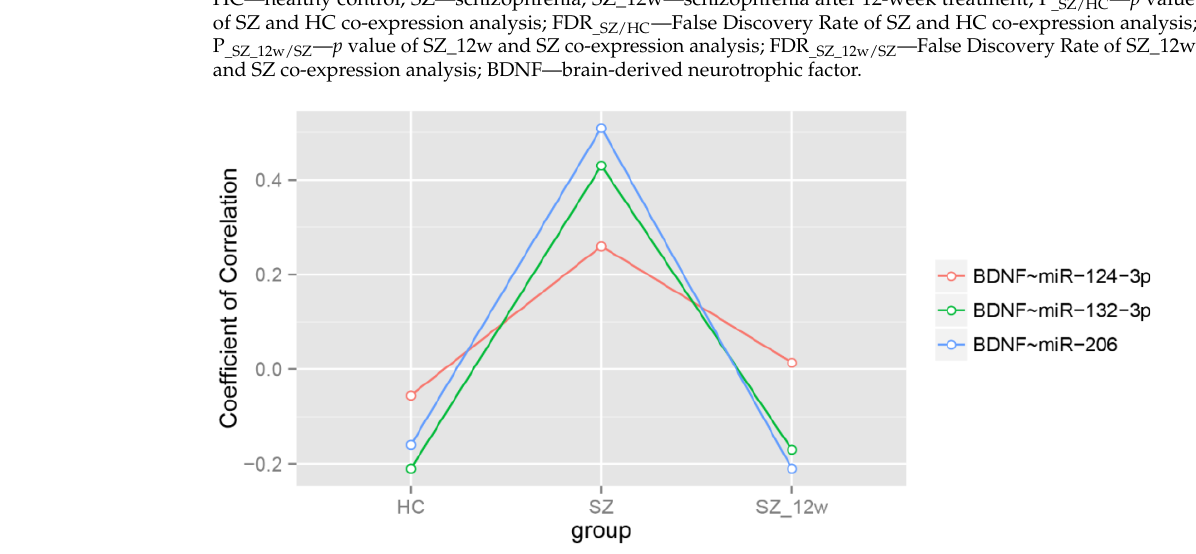
Figure 2. Partial Spearman correlation coefficients adjusted by age and